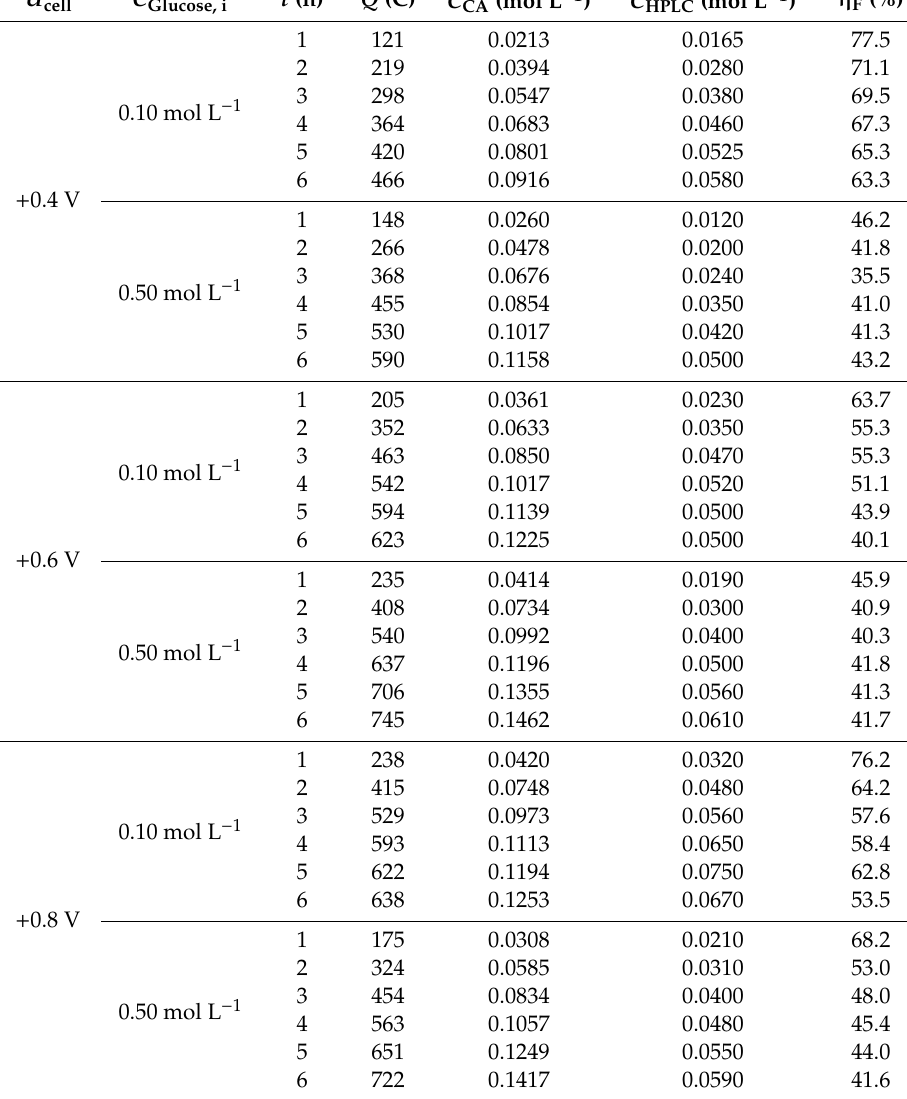
Table 2. Experimental data for glucose electro-reforming: cell voltages ( U cell ), initial glucose concentrations ( C Glucose, i ), coulombic charges involved ( Q ), corresponding gluconate concentrations if two electrons are exchanged per glucose molecule oxidized ( C CA ), gluconate concentrations determined by HPLC ( C HPLC ) and faradaic yields ( η F